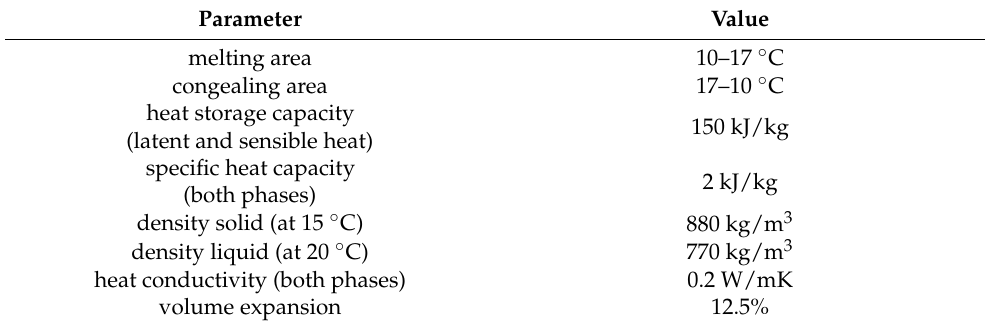
Figure 8. Partial enthalpy distribution as a function of temperature for the phase change material RUBITHERM RT15 [23]. Table 3. Summary of the primary thermo-physical properties of RUBITHERM RT 15